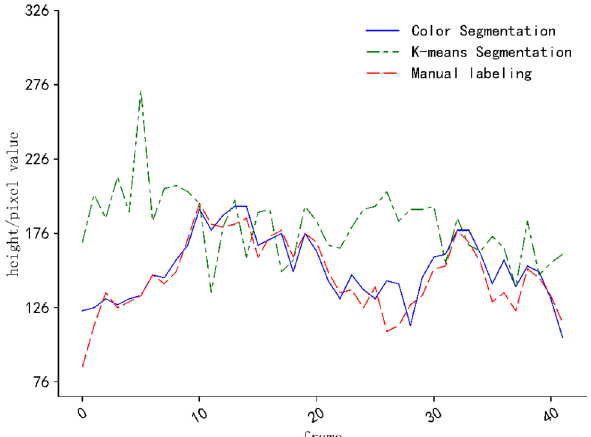
Fig. 8 Rice height line chart